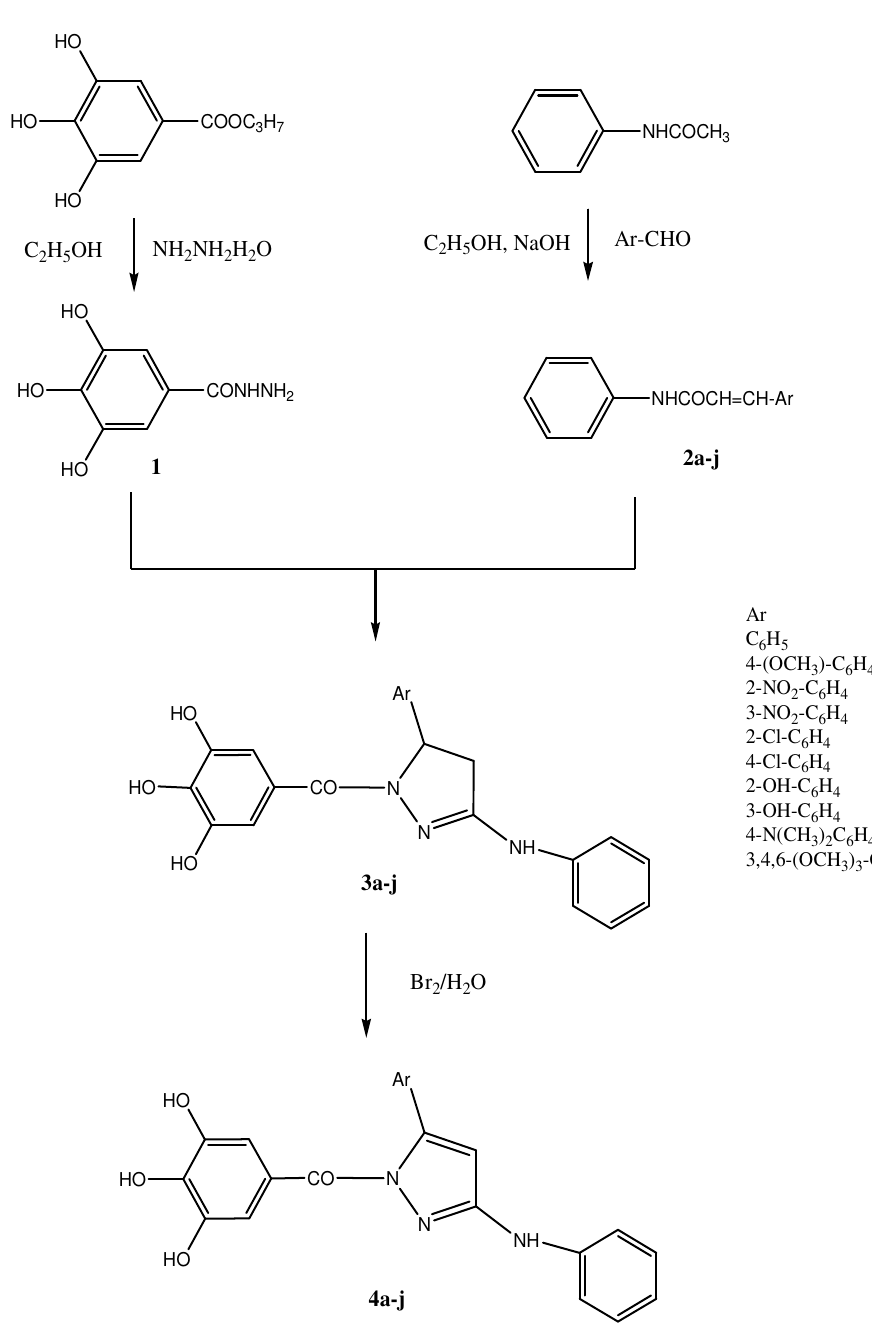
Scheme 1. Synthetic route to pyrazole derivatives of gallic